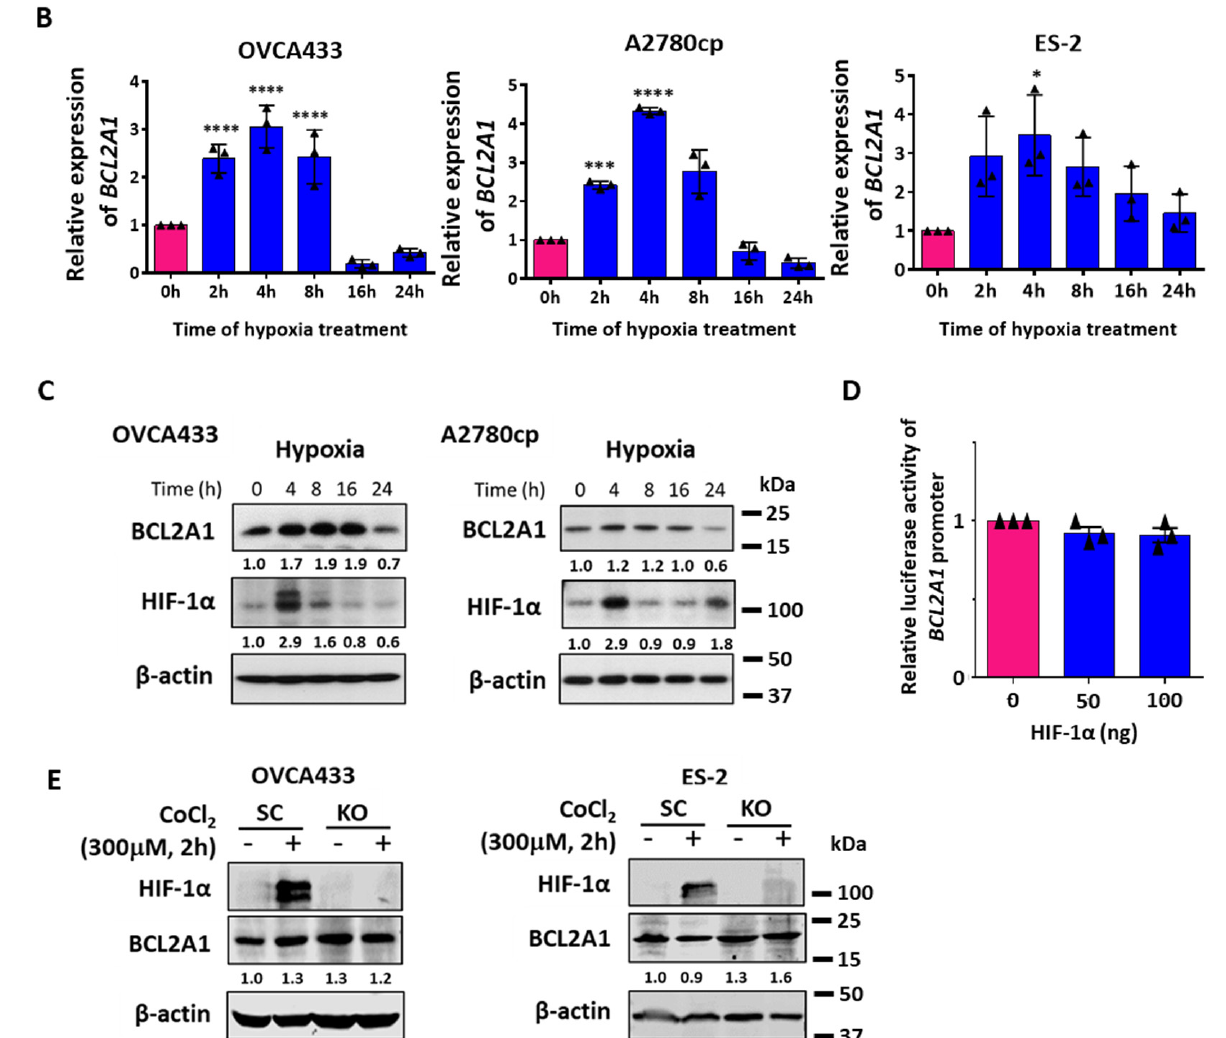
Figure 1. Identification of BCL2A1 as a hypoxia-inducible gene in ovarian cancer. ( A ) A panel of gynecological cancer cell lines (OVCA433, A2780cp, SKOV3, OV2008, and C13*) was treated with hypoxia (0.5% O 2 , 24 h) or normoxia. The gene expression profiling was analyzed using the GeneChipTMAffymetrix Human Genome U133 Plus 2.0 Array (performed by the Center for Genomic Sciences, HKU). Genes with red bar were upregulated genes, while genes with blue bar were downregulated genes with 2 folds in expression. The height of the bar indicated the fold change difference of the respective gene. ( B ) QPCR analysis and ( C ) Western blot analysis showed the relative expression changes of BCL2A1 in OVCA433 and A2780cp cells with hypoxia treatment (0.5% O 2 ) for various time points as compared with the normoxia (0 h). The expression of HIF-1 α was used as the positive indicator of cell response factor to hypoxia stress. β -actin was used as a loading control for Western blot analysis. (* p < 0.05 vs. 0 h, *** p = 0.001 vs. 0 h, and **** p < 0.0001 vs. 0 h). ( D ) BCL2A1 promoter-luciferase plasmid was transiently transfected with HIF-1 α expressing plasmid with various doses (0, 50, and 100 ng) into OVCA433 cells and showed that HIF-1 α had no effect on transcriptional activity of BCL2A1. ( E ) CRISPR/Cas9 gene knockout system was used to delete endogenous HIF-1 α in OVCA433 and ES-2 cells. SC = scrambled control and KO = HIF-1 α − / − . CoCl 2 (300 µ M, 2 h) (Sigma-Aldrich, St. Louis, MI, USA), a chemical HIF-1 α inducer, was used to simulate the hypoxic effect on ovarian cancer cells. For all functional studies, n = 3 technical replicates per sample. Data were represented as mean ±